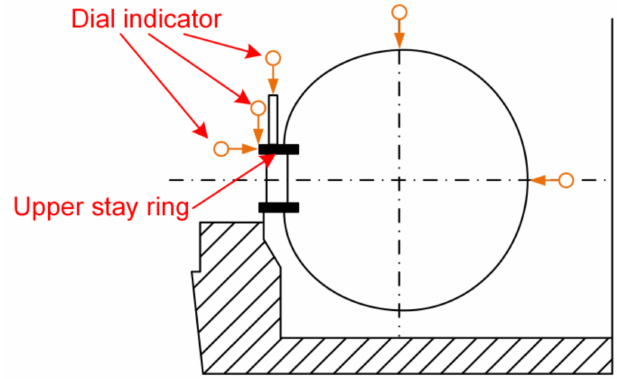
Figure 10. The arrangement of dial indicators.